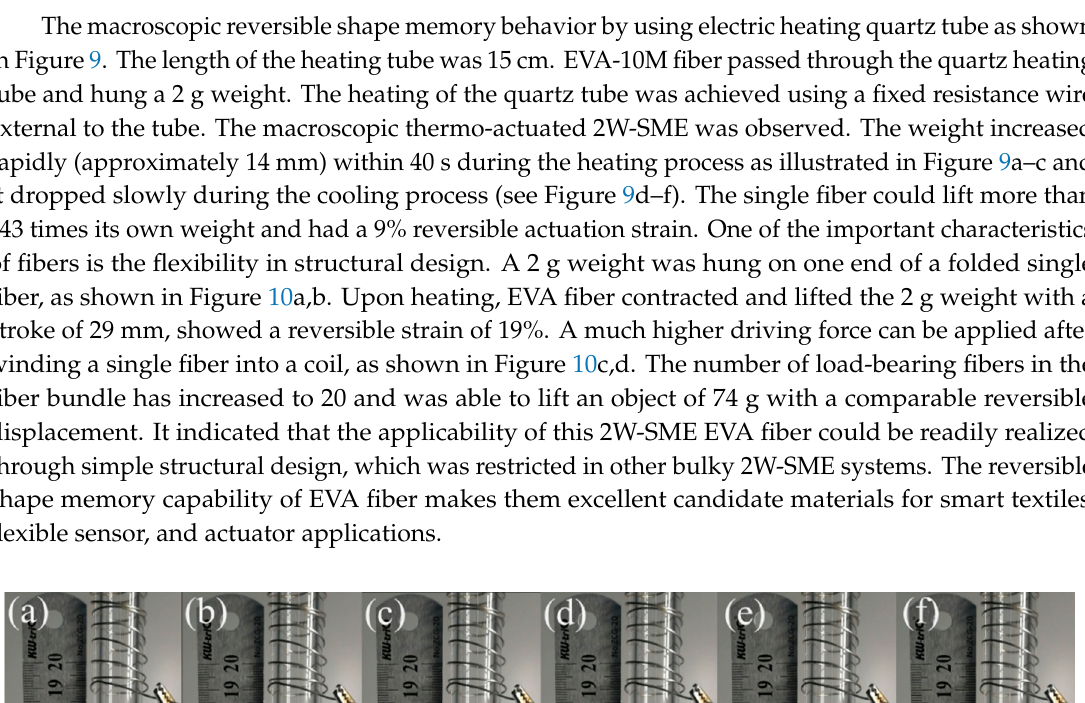
Figure 9. Digital photographs showing the 2W-SME of the EVA-10M fiber under constant stress.